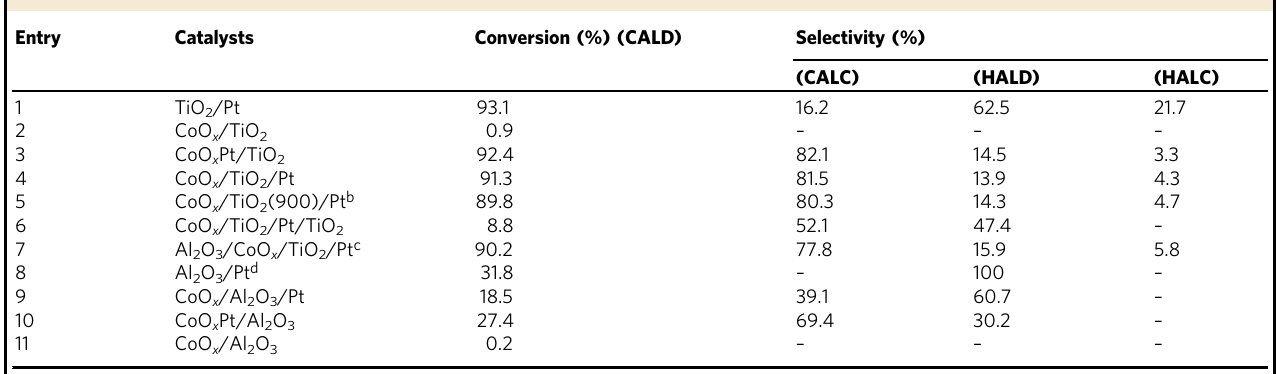
Table 1 Selective hydrogenation results of CALD over the different catalysts a